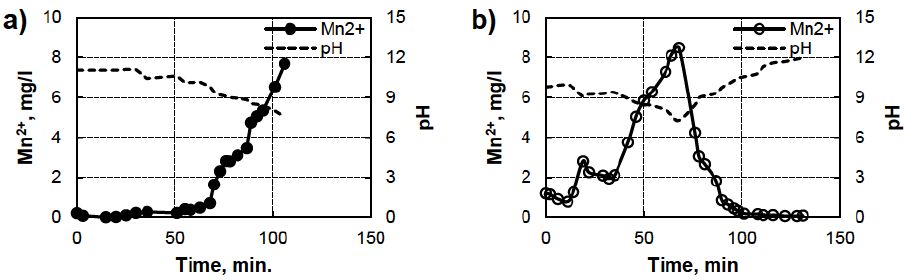
Figure 7: Concentration of Mn 2+ in the output purified mining water as a function of pH, measured by TD-NMR, on day 1 (a) and day 2